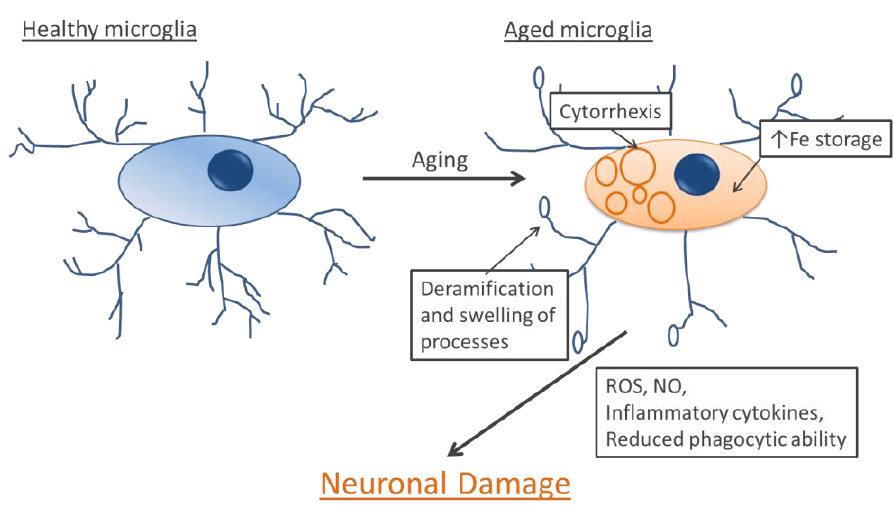
Figure 3. Age-related changes in microglia. When microglia age they lose some of their processes and develop abnormalities in others. Additionally, they often exhibit cytoplasmic fragmentation. They also store more iron. Their increased release of neurotoxic substances and reduced ability to phagocytose debris and toxic protein aggregates leaves neurons